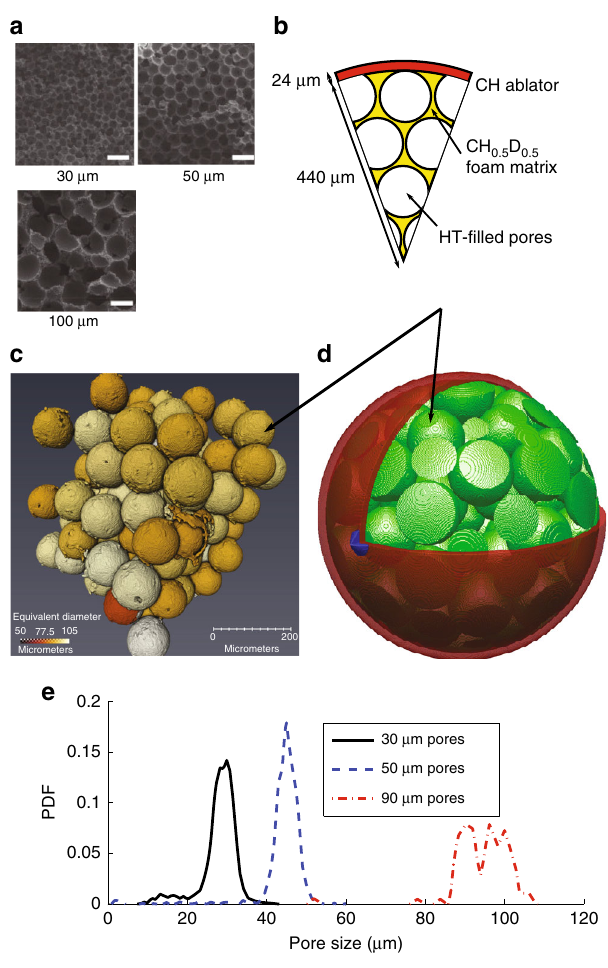
Fig. 1 Initial con fi guration of experiments and simulations. a Scanning electron microscope image of engineered foams 44 showing different macro-pore sizes. b Capsule diagram; foam matrix is open cell, containing sub-micron pores that are also fi lled with HT. c Visualization of pores (solid spheres are macro-pores), colored by diameter, for 90 μ m pore foam sample. d Visualization of initial conditions for 3D simulation with 90 μ m pores; red: shell, green: foam pores ( fi lled with HT), blue: glue spot for target mount. e Probability distribution function (PDF) of pore